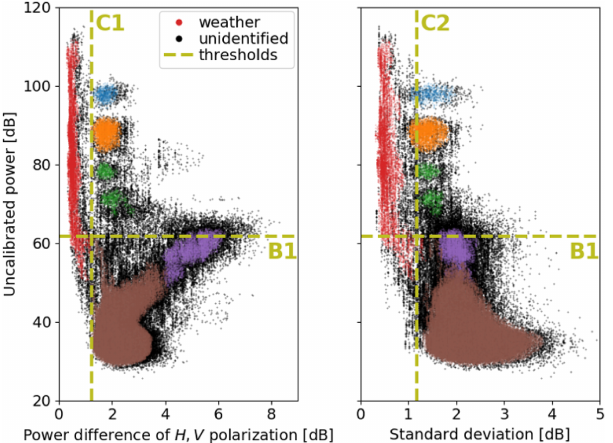
Figure 3. Summary of polarimetric parameters corresponding to Fig. 1, as defined in Sect. 2.2: (a) absolute difference between the two polarization channels and (b) variability expressed through the standard deviation of the differences between both polarization channels within a small neighborhood.